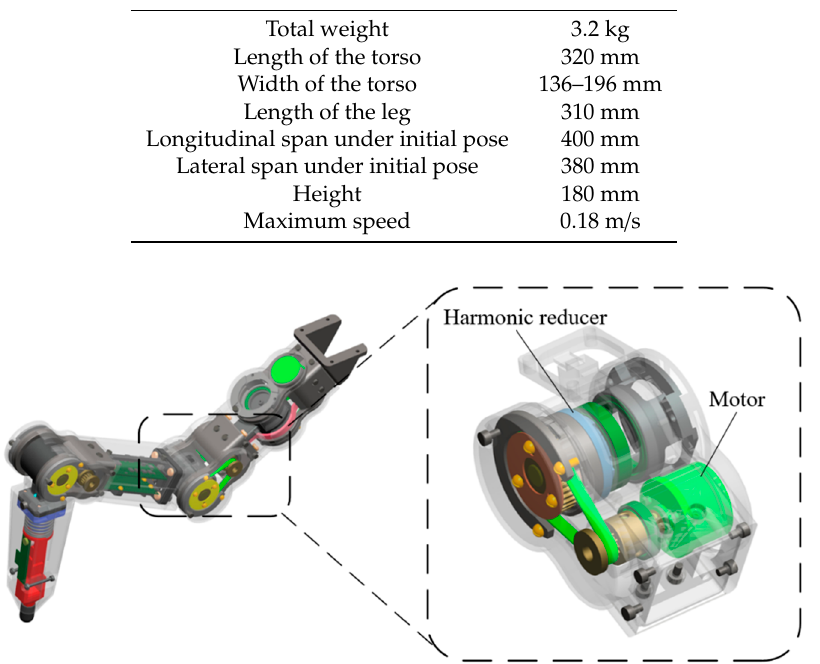
Figure 4. The structure of modularized joint.